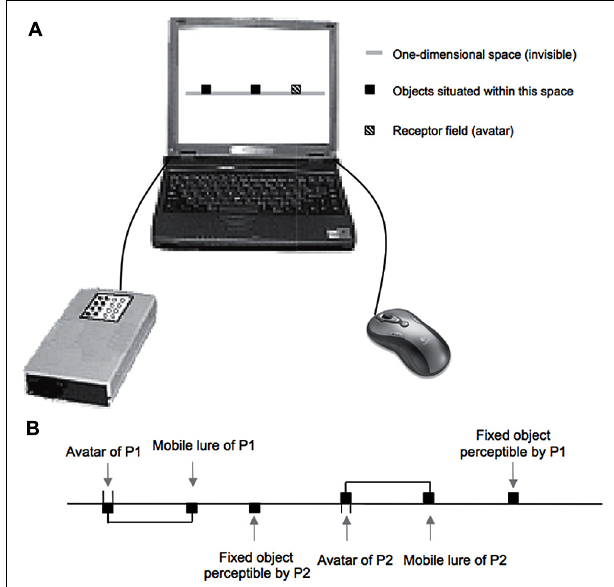
FIGURE 1 | Experimental set-up ofAuvray etal. (2009). (A) Technological device set up by Auvray etal. (2009). (B) Schematic illustration of the (invisible) virtual environment. Movements of the mouse displaced the receptor field of an avatar in a one-dimensional virtual environment. Whenever the receptor field overlaps the current position of another entity, the participant that manipulates this avatar receives a tactile stimulation. Reprinted from Auvray etal. (2009), with permission from